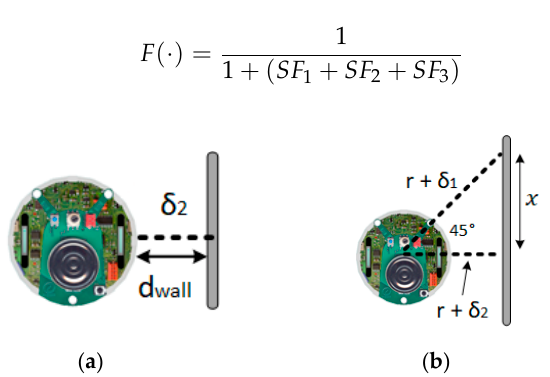
Figure 13. Definition of ( a ) 𝑑 (cid:3050)(cid:3028)(cid:3039)(cid:3039) and ( b ) degree of parallelism